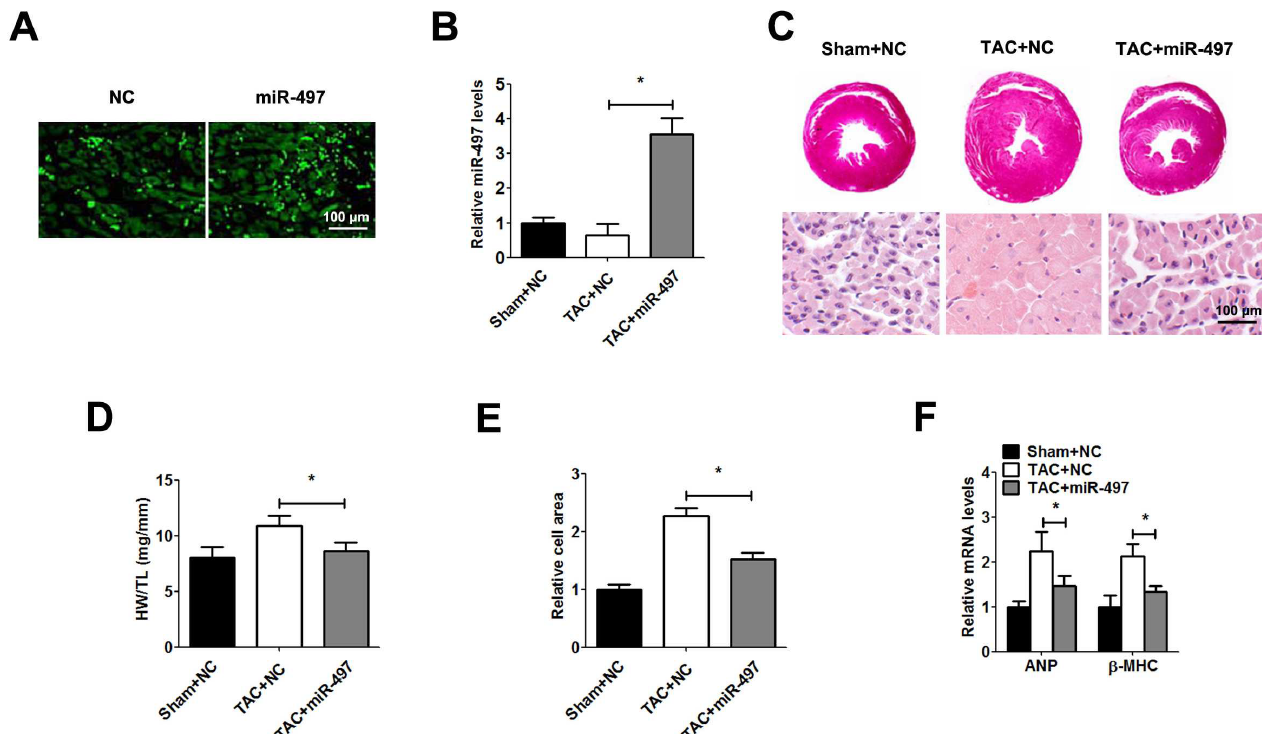
Fig 3. miR-497suppressescardiac hypertrophy in vivo. Mice were subject to chest reopening injection with Leti-miR-497 or Leti-NC (3.5 × 10 7 viral particles per mice). a: Representative image of GFP in myocardium under a fluorescence microscope. b: miR-497determinedby qRT-PCR. c: Morphologic and histological analysisof hearts from different groups using H&E staining. d: The ratio of heart weight to tibial length. e: Relativecell area of cardiomyocytes detected by randomly measuring 10 cells from each section. f: ANP and β -MHC mRNA expressionmeasured by qRT-PCR. Data are shown as the mean ± SD; * , P < 0.05, n =